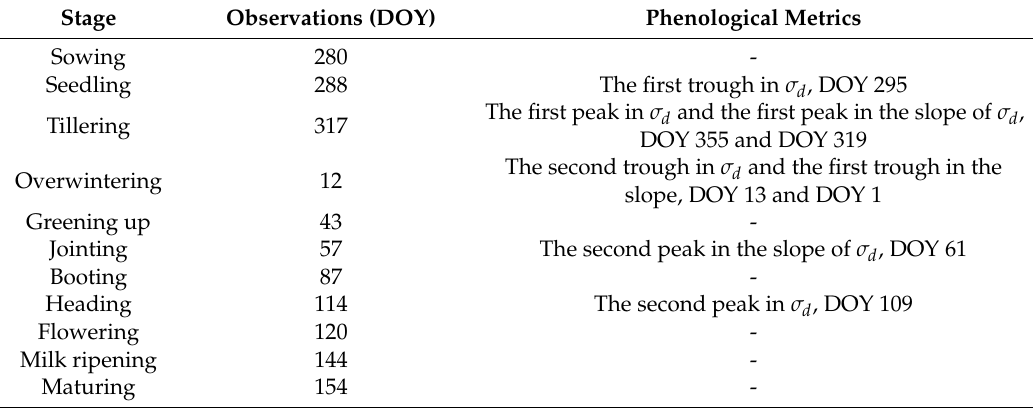
Table 4. Phenological metrics of Sentinel-1 backscatter time